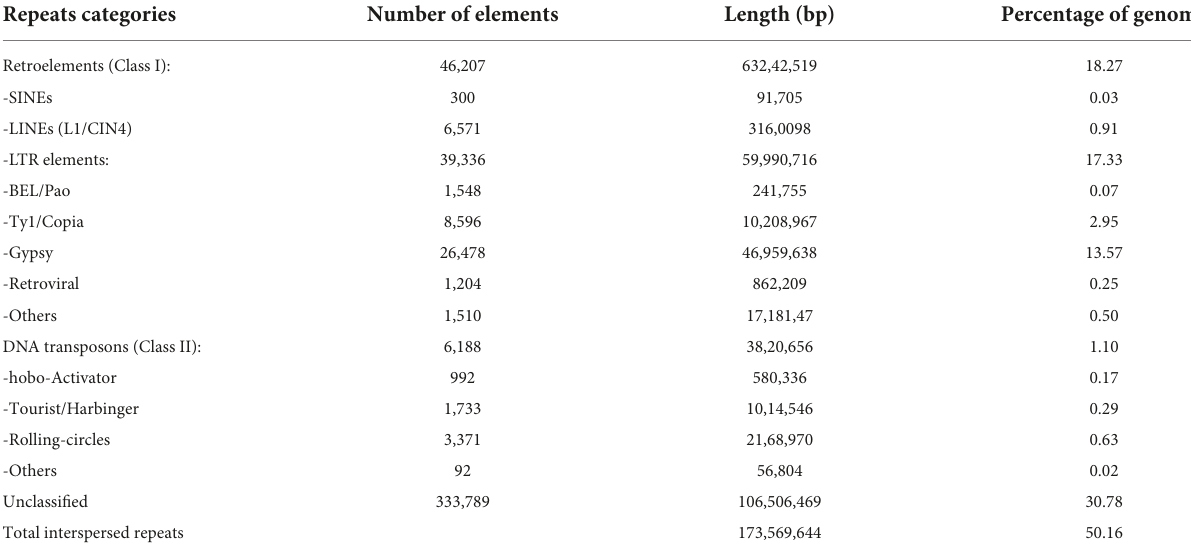
TABLE 4 Different types of repeat elements identified in the ‘Bhagawa’ genome.